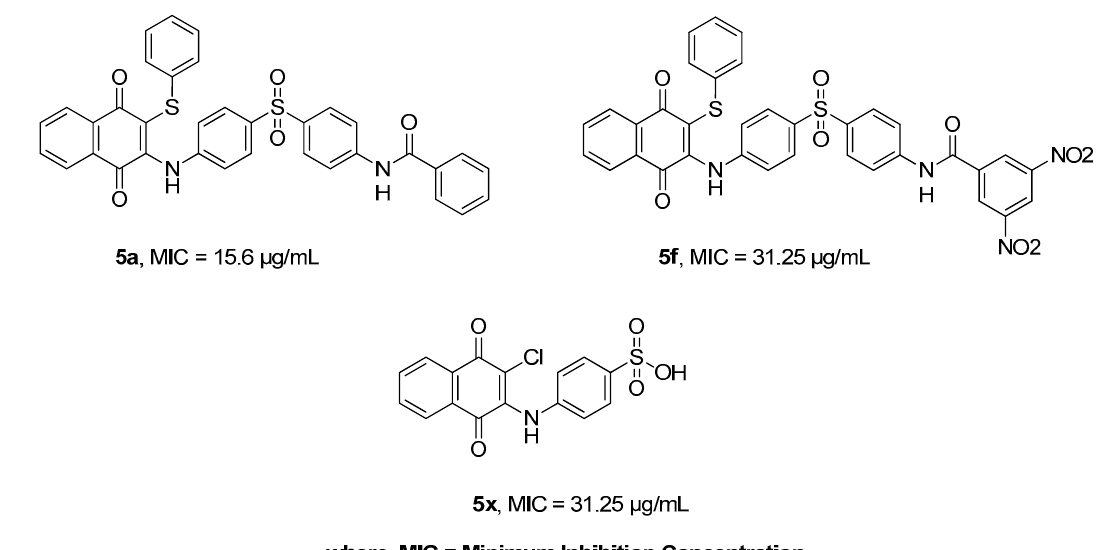
Figure 1. The structures of most active naphthoquinones from the current library .